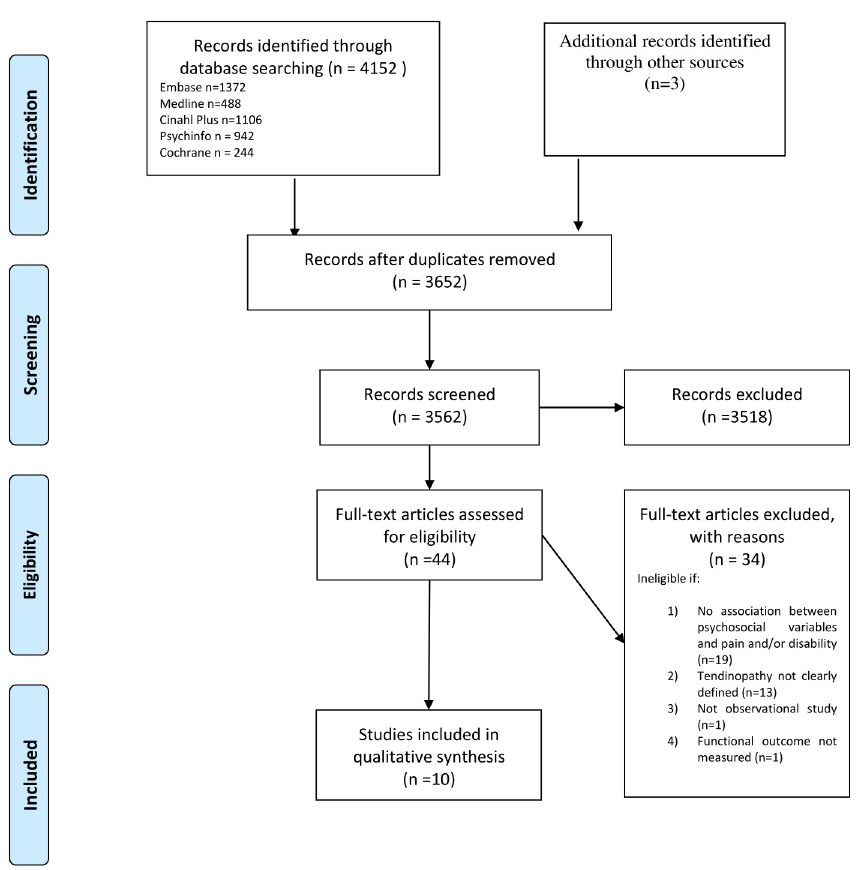
Fig 1. PRISMA flow diagram. Moher D, Liberati A, Tetzlaff J, Altman DG, The PRISMA Group (2009). P referred R eporting I tems of S ystematic Reviews and A nalyses: The PRISMA Statement. Plos Med 6(7): e1000097. doi:10.1371/ journal.pmed1000097 For more information, visit www.prisma-statement.org.